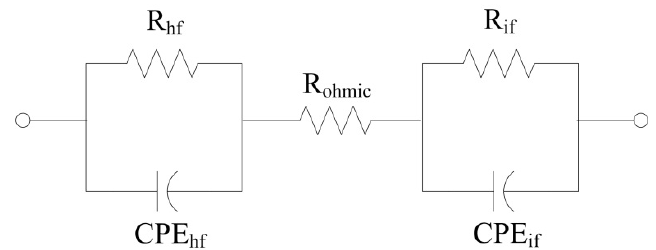
Figure 2. Equivalent circuit with constant phase elements (CPE) used in this